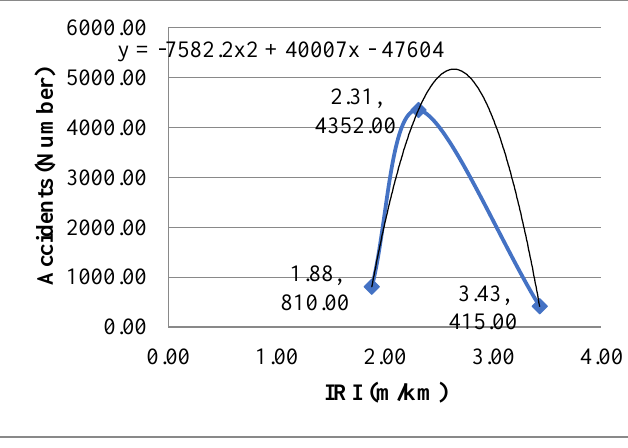
Fig. 8. IRI vs. Accident Data